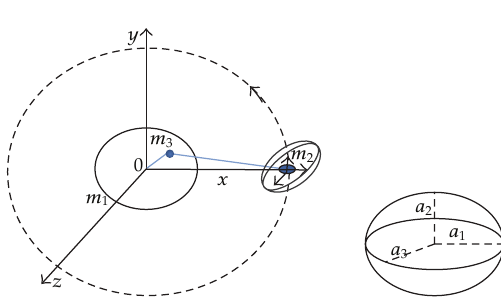
Figure 1: The Robe’s CRTBP with oblate